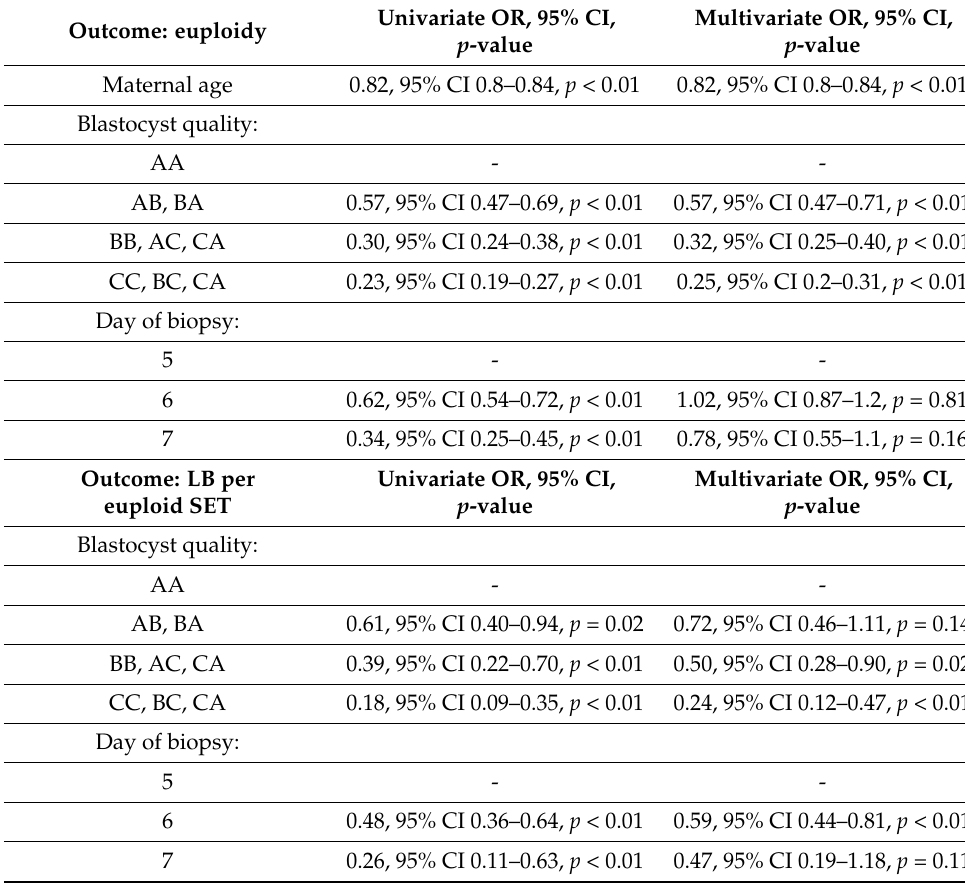
Table 2. Logistic regressions for the association between embryologists’ assessment with euploidy (adjusted for maternal age) and live birth (LB) after euploid single embryo transfer (SET). Univariate OR, 95% CI, Multivariate OR, 95% CI, Outcome: euploidy p -value p -value Maternal